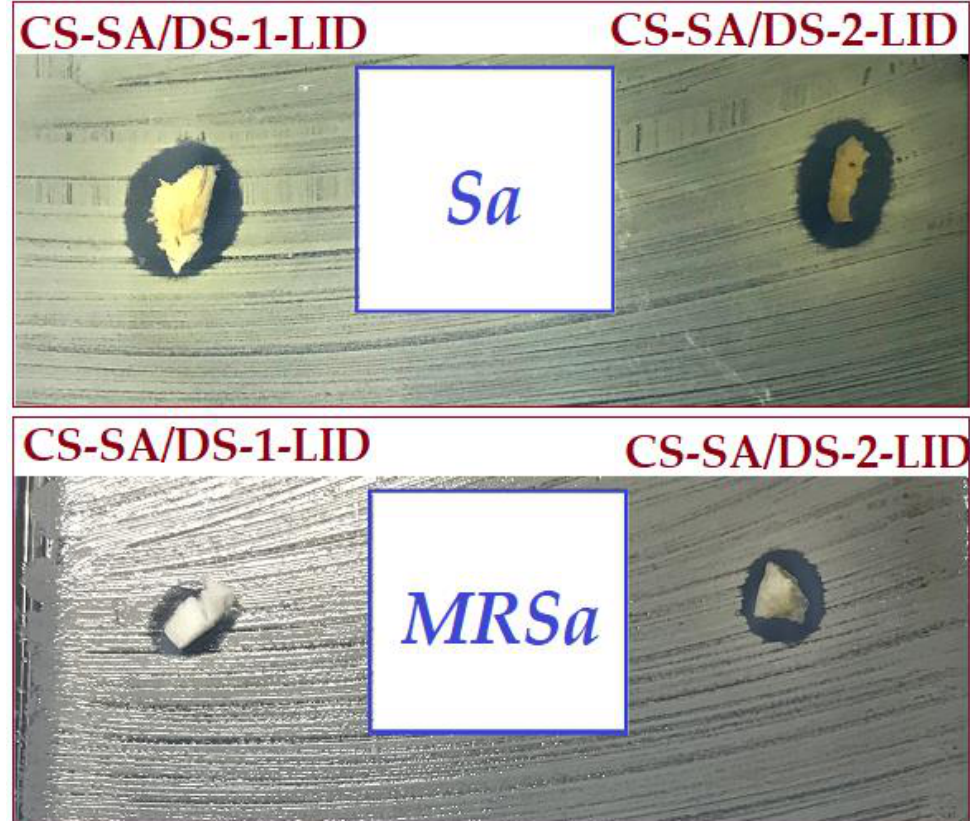
Figure 8. Antibacterial activity of lidocaine-charged porous membranes against Staphylococcus aureus ( Sa ) and Methicillin-resistant Staphylococcus aureus ( MRSa ).